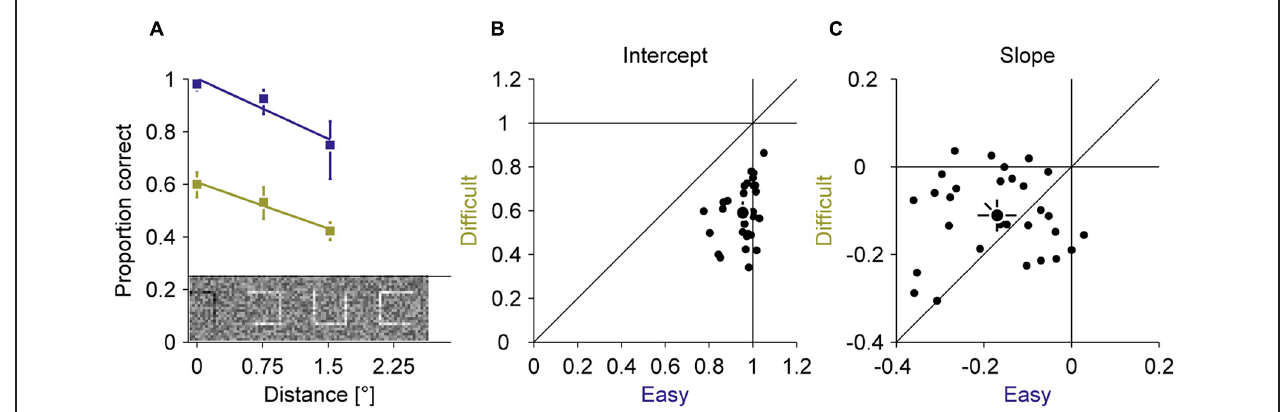
FIGURE 2 | Experiment 1, perceptual performance during fixation. Difficult and easy conditions are shown in yellow and blue, respectively. (A) Average proportion correct as a function of the squares eccentricity. (B) Intercept of the linear fits from (A) . (C) Slopes of the linear fits from (A) . Small dots represent data for individual observers; large dots represent the mean across observers; Error bars represent 95% confidence